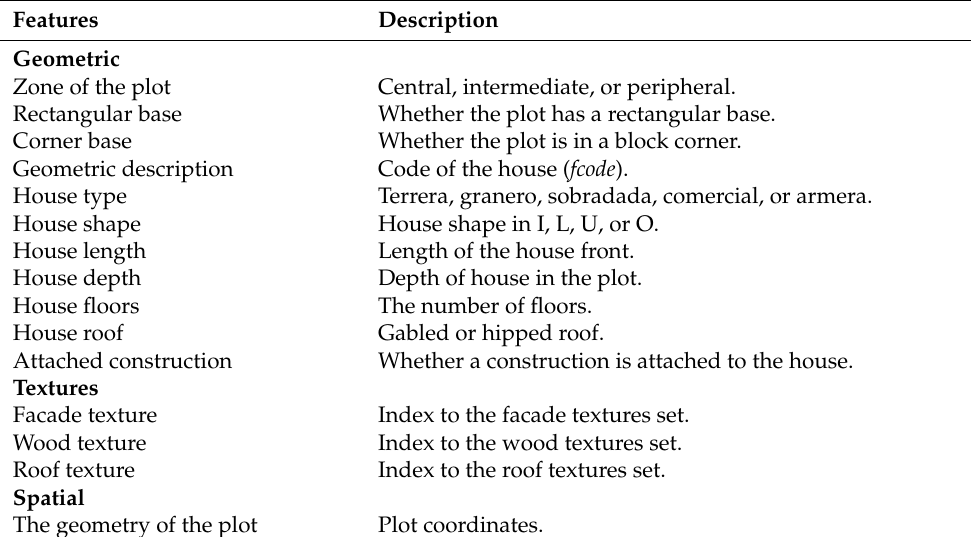
Table 4. An implicit model for 3D house reconstruction.